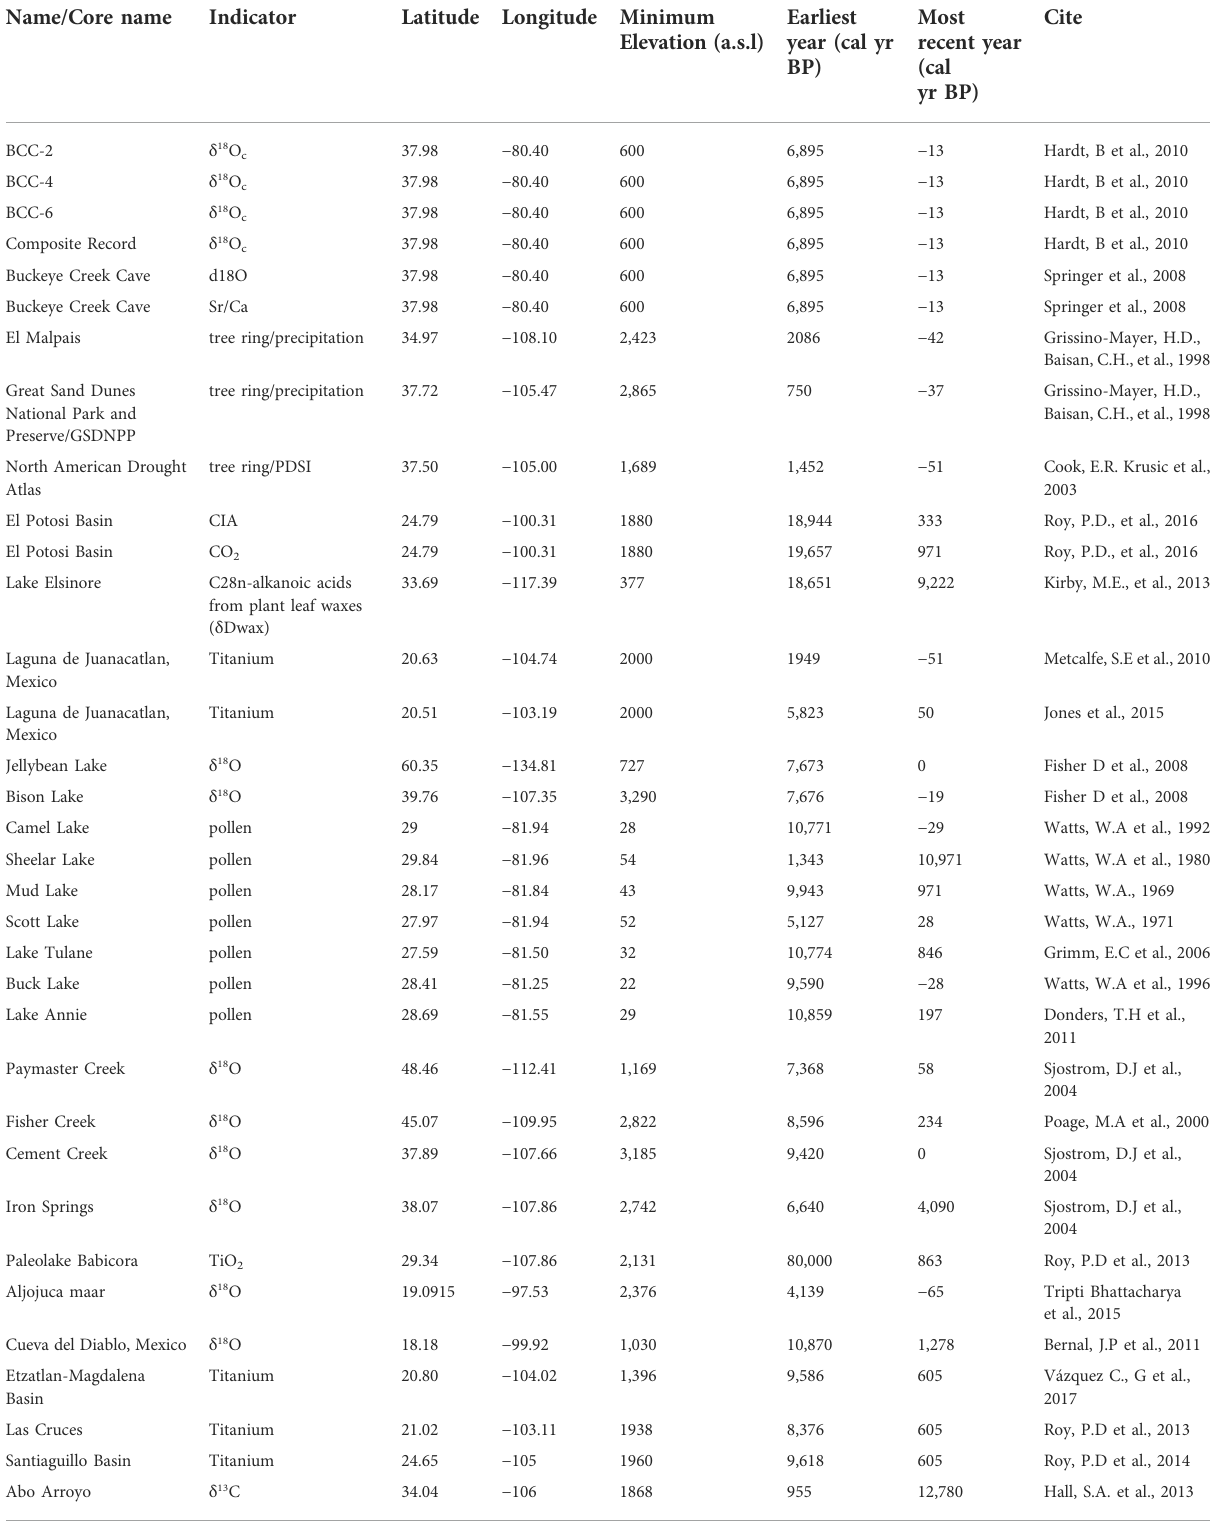
TABLE 3 Proxies are selected to reconstruct past precipitation. Name/Core